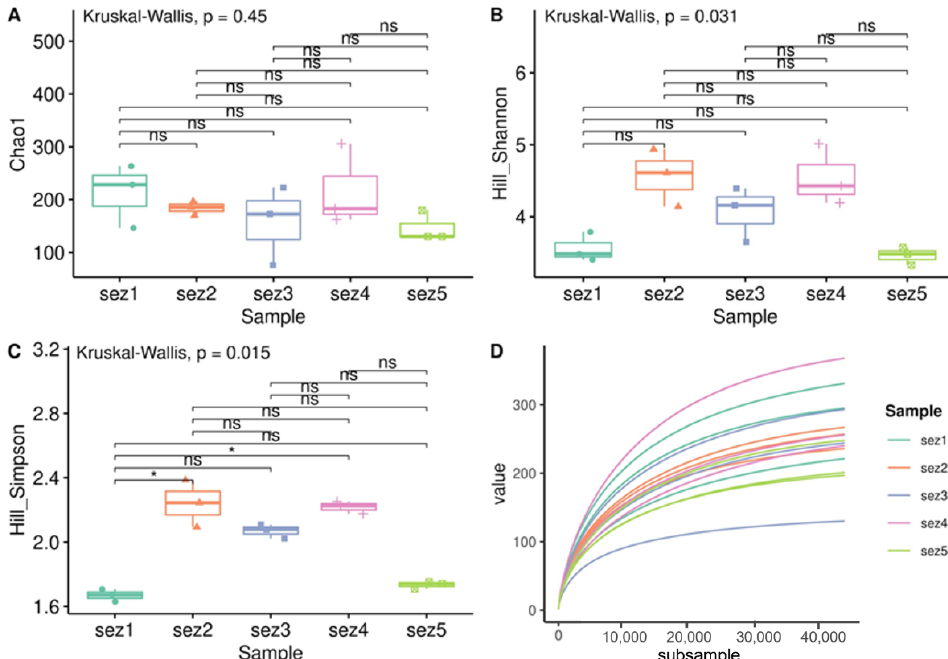
Figure 5. Bacterial community analysis: ( A ) α -diversity represents the Chao1 index; ( B ) Hill–Shannon; ( C ) Hill–Simpson index, each calculated after rarefaction to a coverage of 99.5%, and ( D ) rarefaction curves of observed species of bacterial community composition. Box and whiskers represent the minimum, 1st quartile, median, 3rd quartile, and maximum of each group. The reported p -value is calculated by the Kruskal–Wallis test ( α = 0.05); the post-hoc statistical test is based on the Dunn test, with Benjamini–Hochberg corrections for multiple comparisons: Notations for the p -value is the following: ns for p > 0.05; * for p ≤ 0.05.